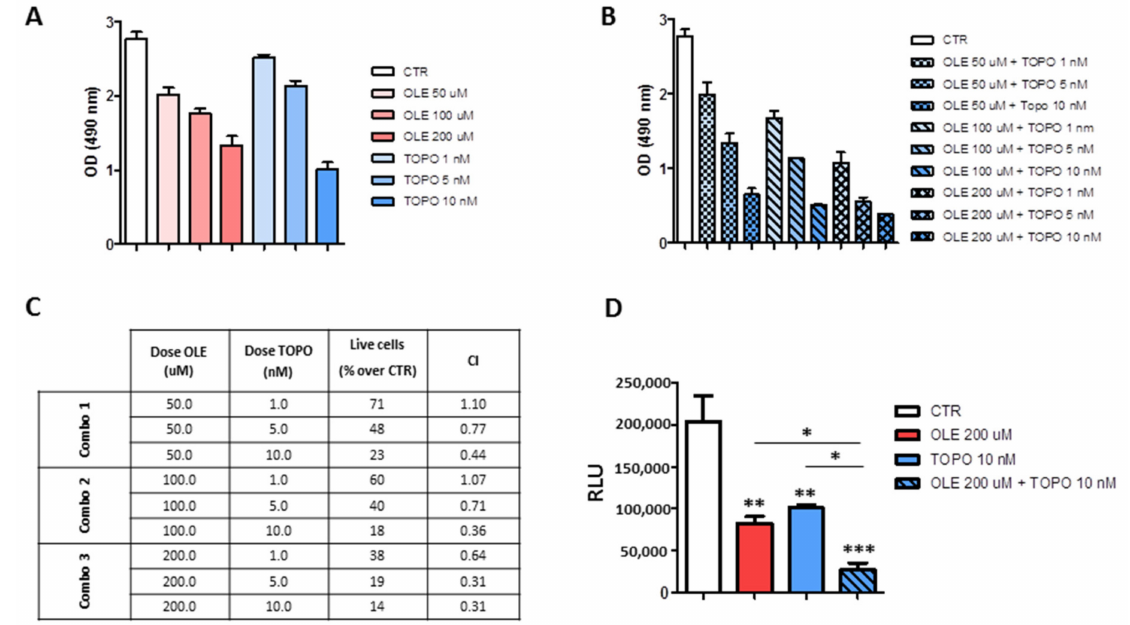
Figure 7. Effects of OLE and topotecan combination on the cell viability of IMR-32 and SH-SY5Y cells. ( A ) MTS assay showing the effects of the single drugs. ( B ) MTS assay showing the effects of drugs combination. ( C ) Table showing the combination index (CI) values for each OLE-TOPO combination. Combo 1 = OLE 50 µ M plus TOPO 1, 5, and 10 nM; Combo2 = OLE 100 µ M plus TOPO 1, 5, and 10; Combo 3 = OLE 200 µ M plus TOPO 1, 5, and 10. CI < 1 means synergism. CI > 1 means antagonism. CI = 1 means addiction. ( D ) Viability assay showing the effects of OLE and TOPO, as single drugs and in combination, on tumor spheroids of IMR-32 cell line. Data are expressed as mean ± SD of three independent experiments (* p < 0.05, ** p < 0.01, *** p < 0.001). CTR: control; OLE: olive leaf extract; TOPO: topotecan; uM: micromolar; nM: nanomolar; OD: optical density; RLU: relative luminescence